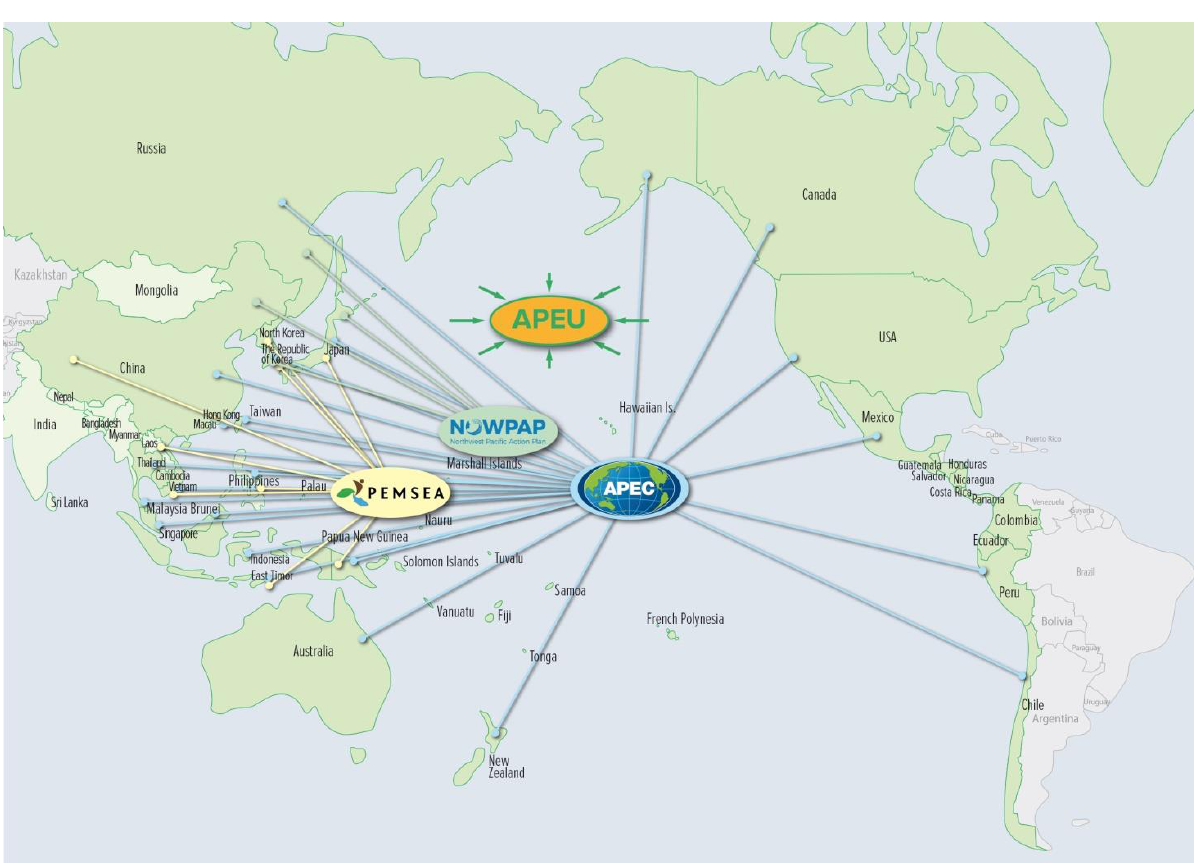
Figure 4. Potential contribution of an integrated maritime policy to development of the Asia-Pacific Environmental Union (APEU).